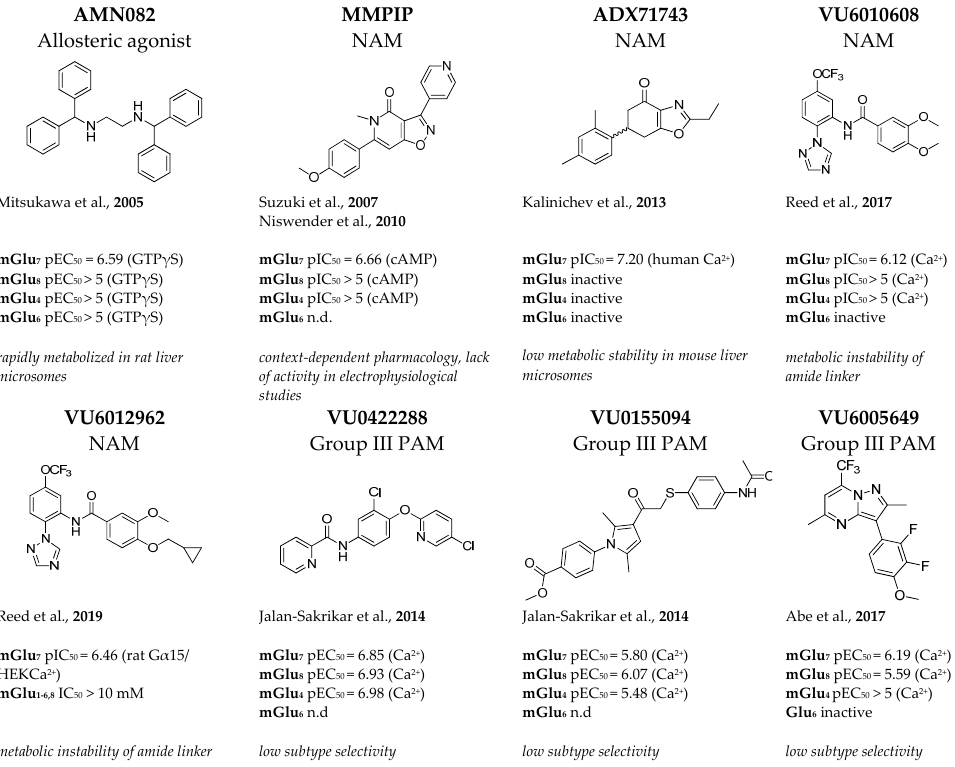
Figure 1. Summary of the first chemical structures of reported mGlu 7 receptor tool compounds (NAM—negative allosteric modulator; PAM—positive allosteric modulator) [13,17,18,20,21,29,36,38,39]. The activity is shown as the pEC 50 /pIC 50 value; assay type is indicated in parentheses: cAMP, cAMP accumulation; Ca 2+ , calcium mobilization; GTP γ S, GTP γ S binding; n.d.—no data. metabolically stable NAM and PAM mGlu 7 modulators, VU6019278 [37] and VU6027459